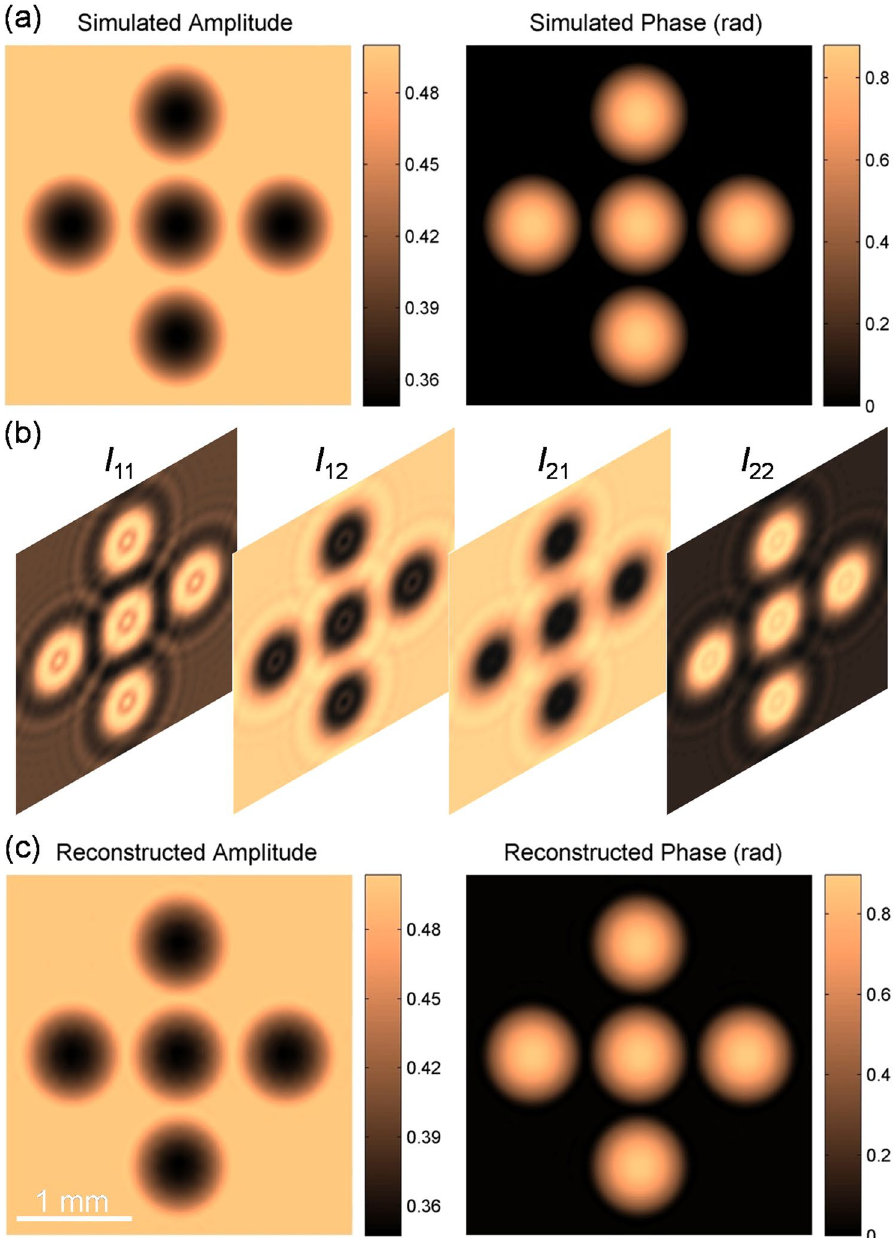
Figure 2. Simulation of TPD-DH in microscopy. ( a ) Amplitude and phase distributions of the object wave used in computer simulation; ( b ) Two-step phase-shifted interferograms; Four interferograms are I 11 , I 12 , I 21 and I 22 from left to right in the figure, respectively. I 11 and I 12 are phase-shifted interferograms in the plane 1 having a distance z 1 = 100 mm from the sample plane; I 21 and I 22 are the counterparts in the plane 2 having a distance z 2 = 105 mm from the sample plane. ( c ) Reconstructed amplitude and phase of the object wave. All pictures in Fig. 2 are exactly the same